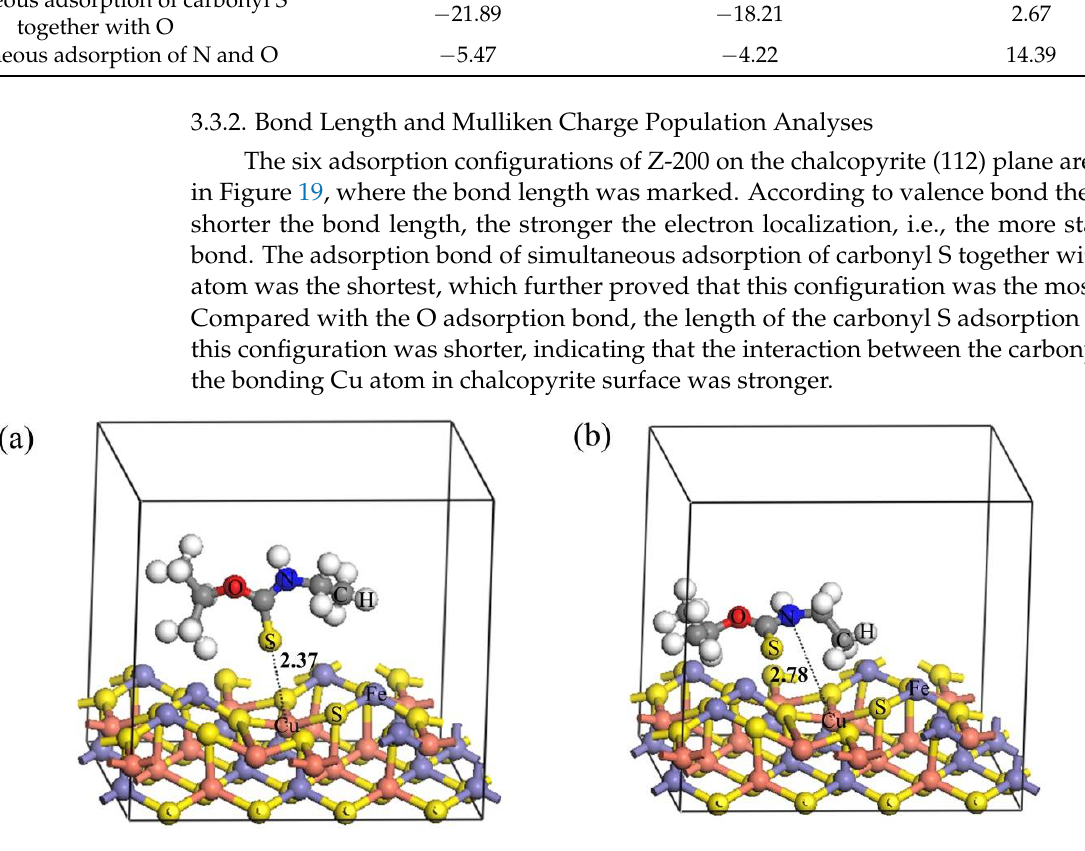
Figure 19. Optimized adsorption configurations of Z-200 on chalcopyrite (112) crystal plane (( a ) adsorption of carbonyl S; ( b ) adsorption of N; ( c ) adsorption of O; ( d ) simultaneous adsorption of carbonyl S together with N; ( e ) simultaneous adsorption of carbonyl S together with O; ( f ) simul- taneous adsorption of N and O). 3.3.3. FTIR Spectrum Analysis The infrared spectra of Z-200, chalcopyrite, and Z-200-adsorbed chalcopyrite are presented in Figure 20. After the adsorption of Z-200, the infrared spectrum of chalcopy- rite changed evidently, suggesting that Z-200 chemisorbed on the chalcopyrite surface [39–43]. Two new strong absorption peaks appeared at 1022.27 cm −1 and 1097.50 cm −1 , which could be separately attributed to C=S-S and C-O-S coupled vibrations. The possi-